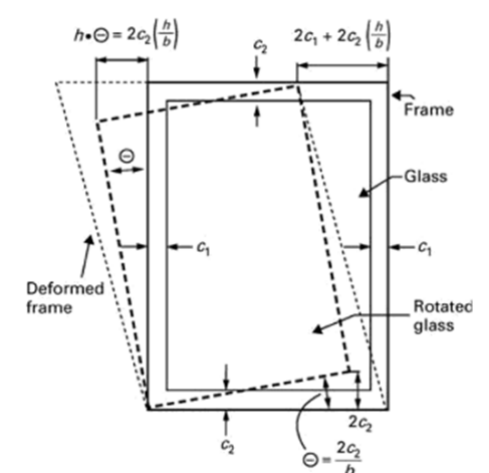
Fig. 1 Illustration showing the definition of clearance terms (Beher